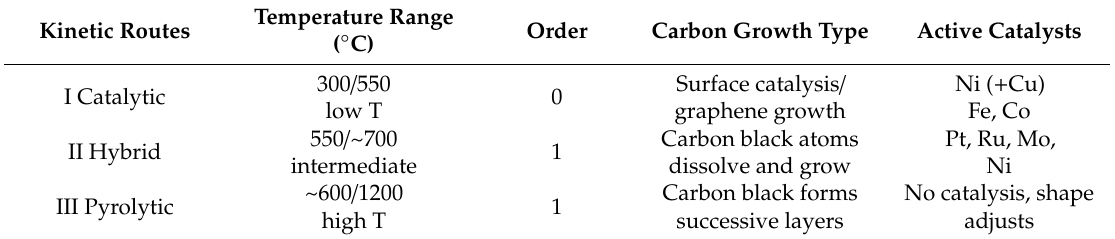
Table 2. Summary of the three di ff erent routes of graphene formation from hydrocarbons over di ff erent temperature / pressure ranges